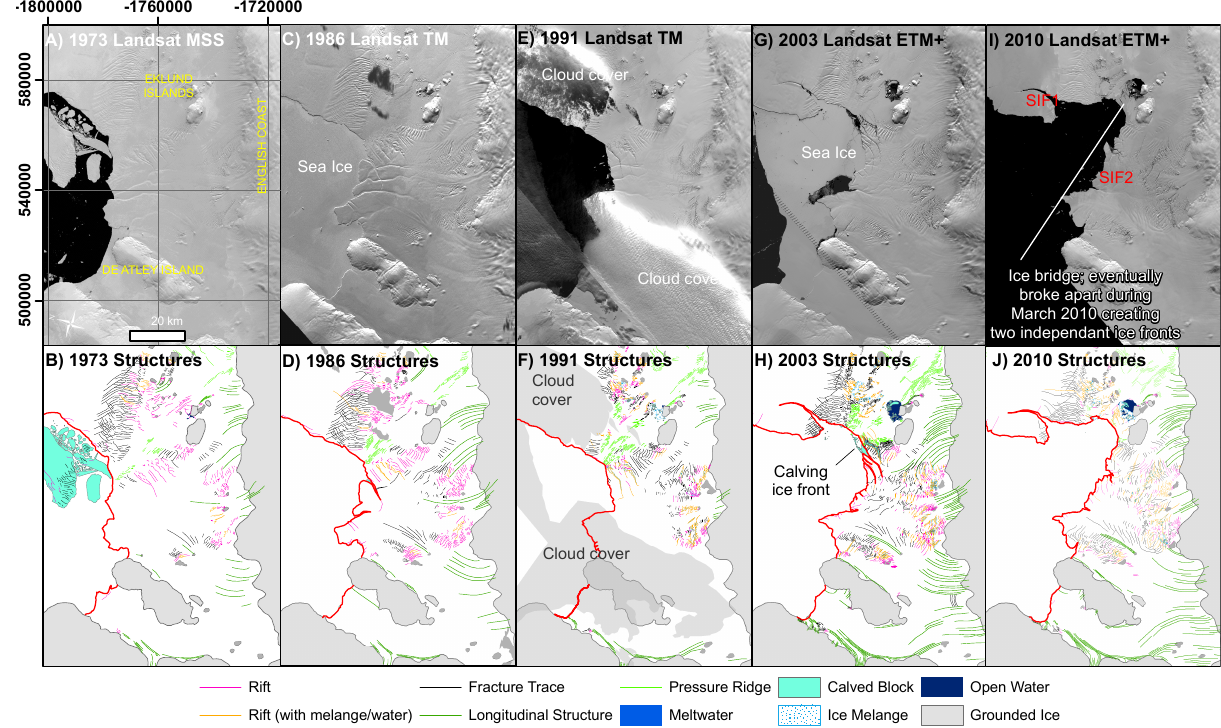
Fig. 5. Structural evolution at the south ice front illustrating widespread rifting lee side of the Eklund Islands and the English Coast. Increased rifting is apparent between the Eklund Islands and De Atley Island. During March 2010, a weak ice bridge north of the largest Eklund Island broke apart leaving two independent ice fronts (SIF1 and